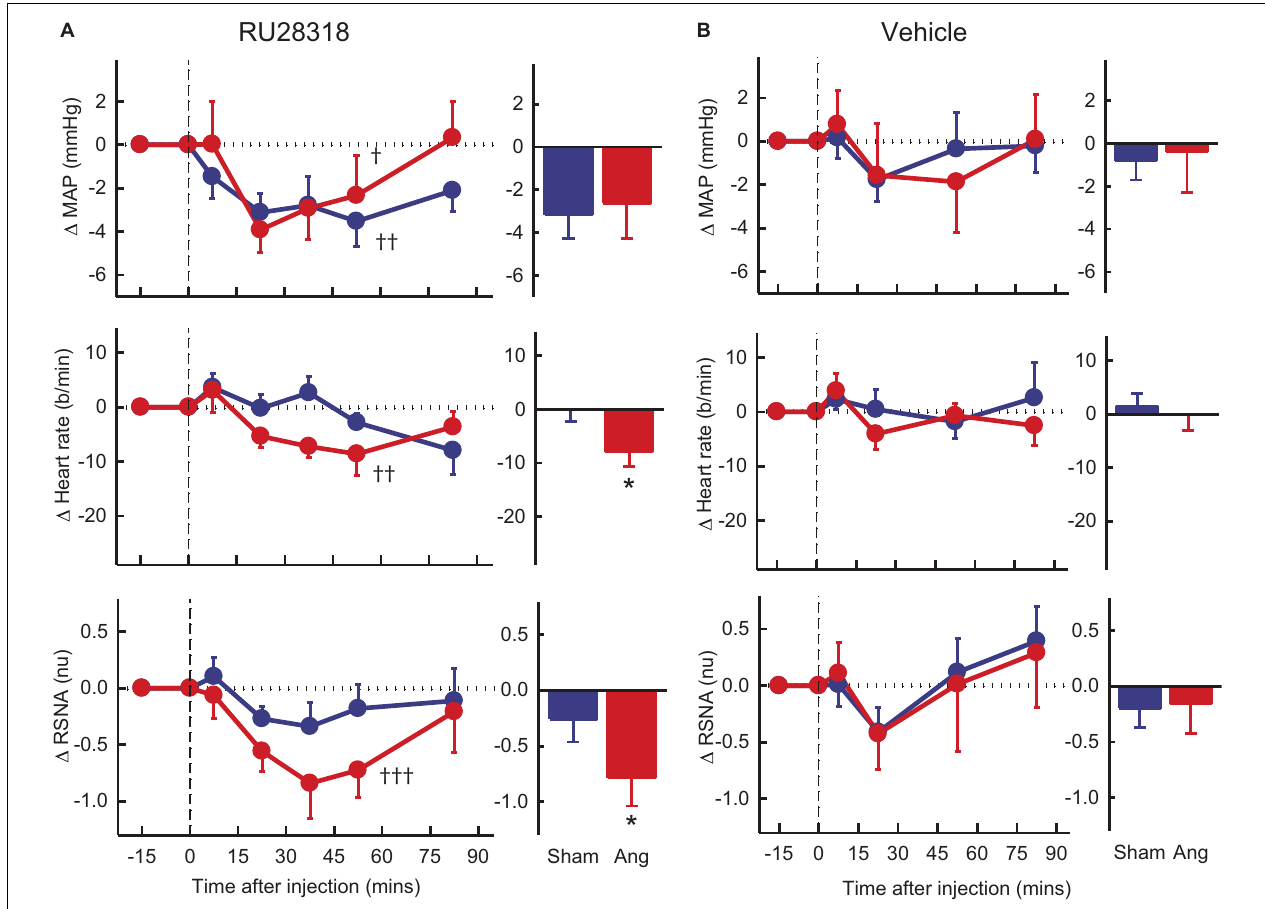
FIGURE 4 | Average changes in mean arterial pressure (MAP), heart rate and renal sympathetic nerve activity (RSNA, normalized units) in rabbits after bilateral injection into the PVN of RU28318 and vehicle. (A) Line graphs are mean difference from control ± SED after RU28318 (0.34 nmol) injection shown at dashed vertical line in sham (blue circles, n = 10) and Ang II (red circles, n = 8) rabbits, † P < 0.05, †† P < 0.01, and ††† P < 0.001 for change from control at 30–60 min. Bar graphs show average difference from control ± SED at 30–60 min, * P < 0.05 for Ang vs sham. Family wise error rate was controlled using a modified Bonferroni procedure. (B) Changes after vehicle Ringers (200 nl) injection, averaged at 0–30